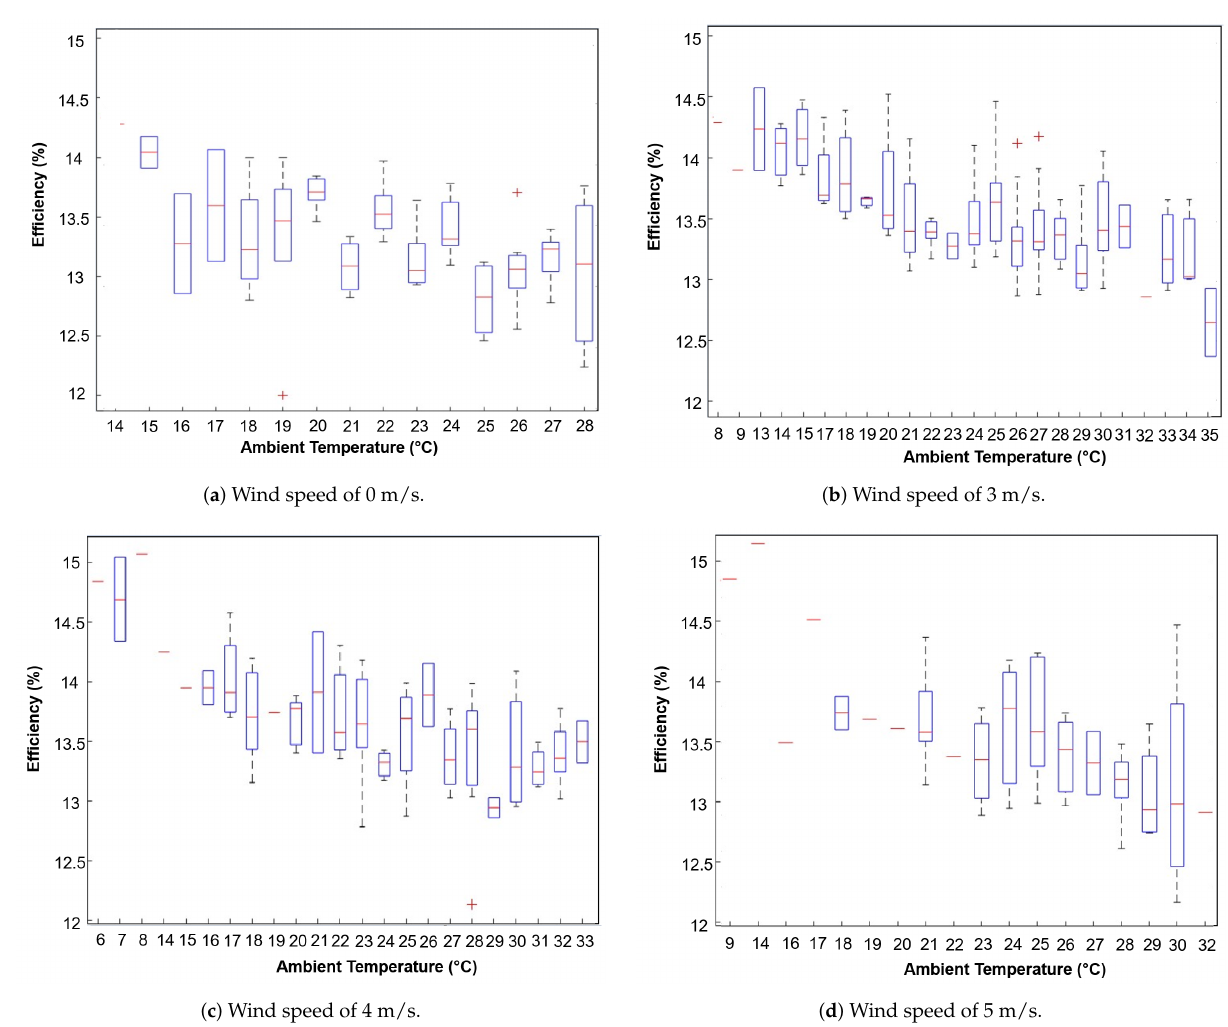
Figure 10. Efficiency vs. temperature at different wind